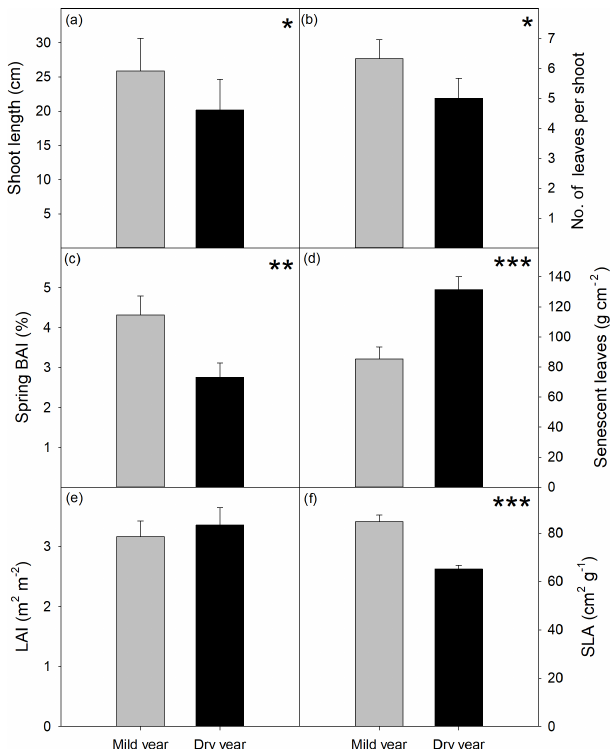
Figure 4. Growth variables evaluated at the end of the growing sea- son in the mild and dry years. (a) Shoot length (cm). (b) Number of leaves per shoot. (c) Basal area increment (BAI, %) expressed as the percentage of basal area at the beginning of each year. (d) Senescent leaves (gm − 2 ). (e) Leaf area index (LAI, leavesm 2 per groundm 2 ). (f) Specific leaf area (SLA, gcm − 2 ). Values are mean ± SEM ( n = 15). Significant differences between years are indi- cated when ∗ p< 0 . 05, ∗∗ p< 0 . 01, ∗∗∗ p< 0 .